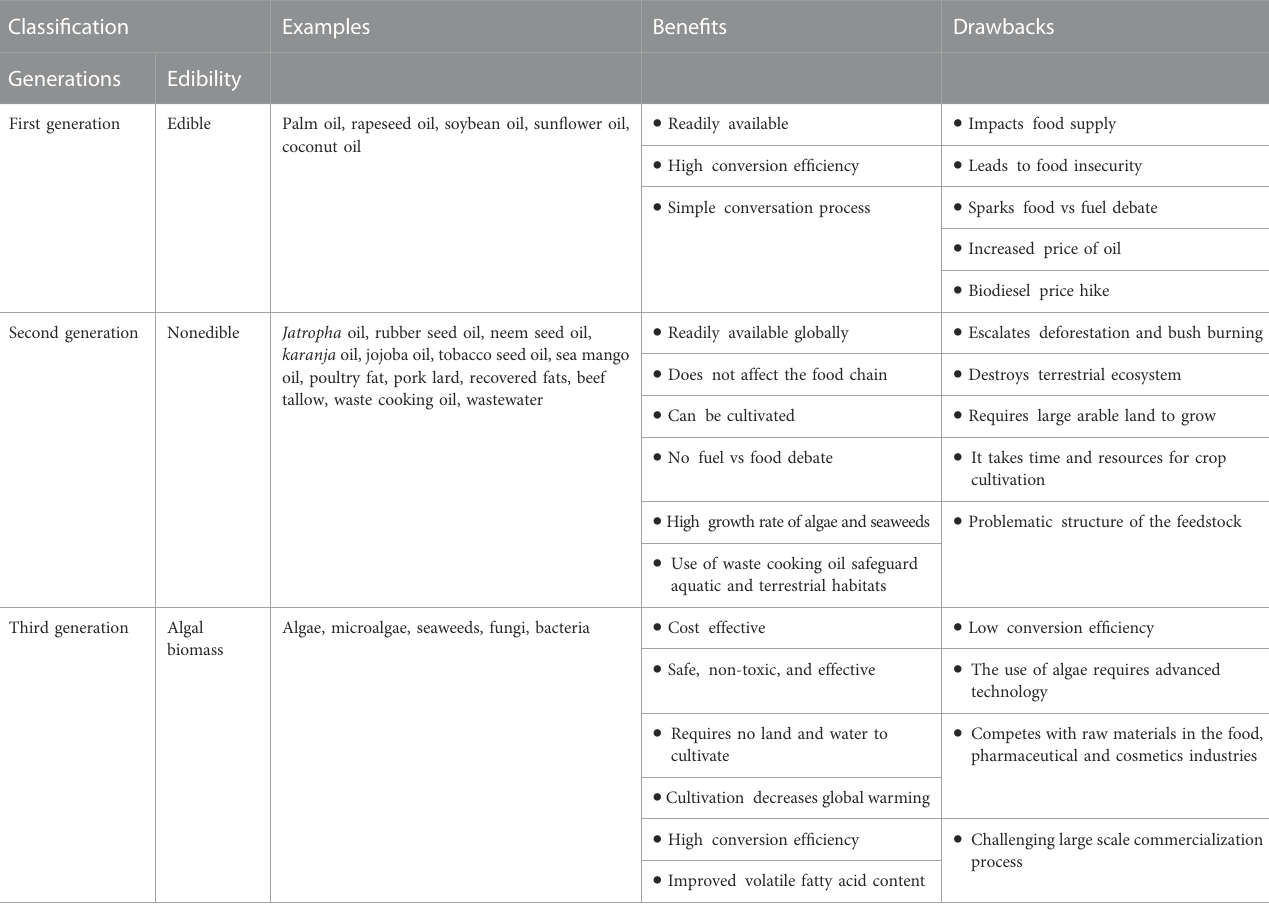
TABLE 1 Classi fi cation of feedstock for biodiesel production (Kesharvani and Dwivedi, 2021; Shaah et al., 2021; Zulqarnain et al., 2021).